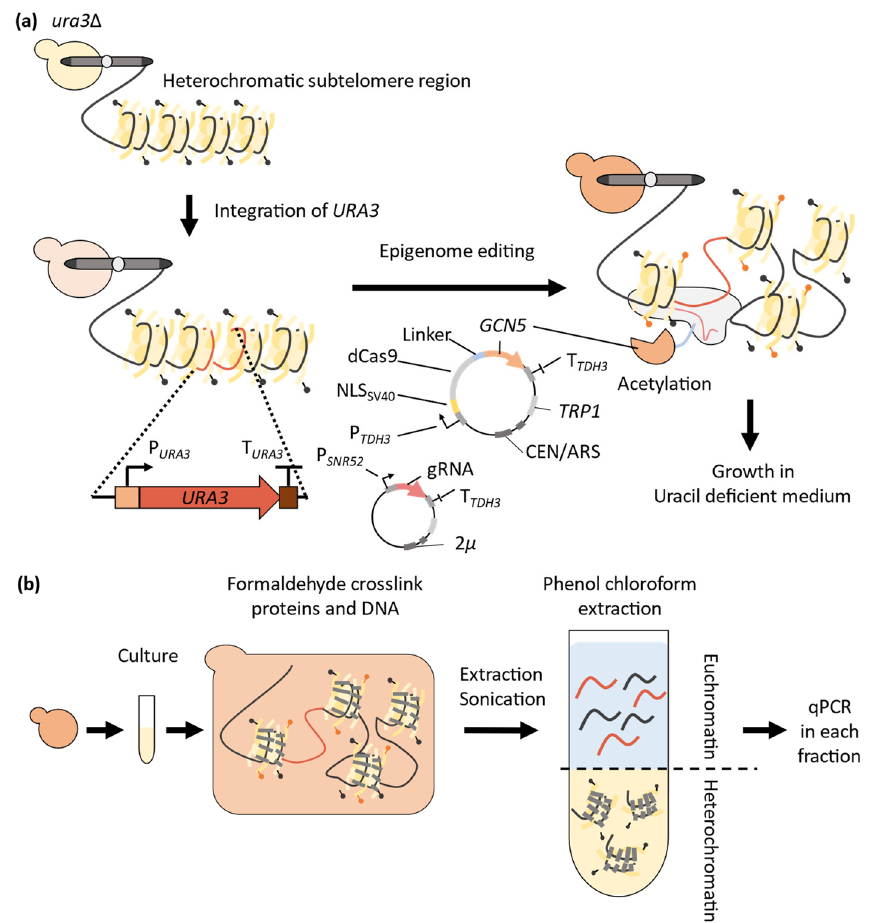
Figure 5. Epigenome editing in yeast for inducing chromatin loosening in the heterochromatic region. ( a ) The dCas9 protein fused with the Gcn5 histone acetyltransferase protein is expressed in yeasts with gRNAs that target the URA3 gene in the subtelomere region. It is expected that Gcn5 is guided to the target region by the dCas9/gRNA complex and acetylates the histones in that region. ( b ) FAIRE-qPCR methods can quantify the chromatin condensation state of specific DNA sequences in the genome using qPCR after protein–DNA crosslinking and some preparation steps